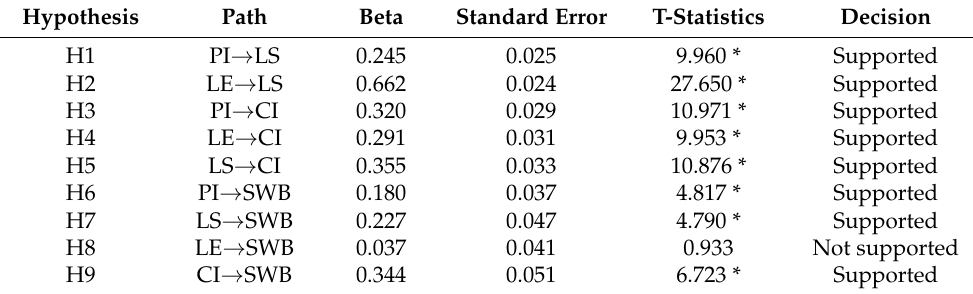
Table 6. The structural relationships and hypothesis testing.